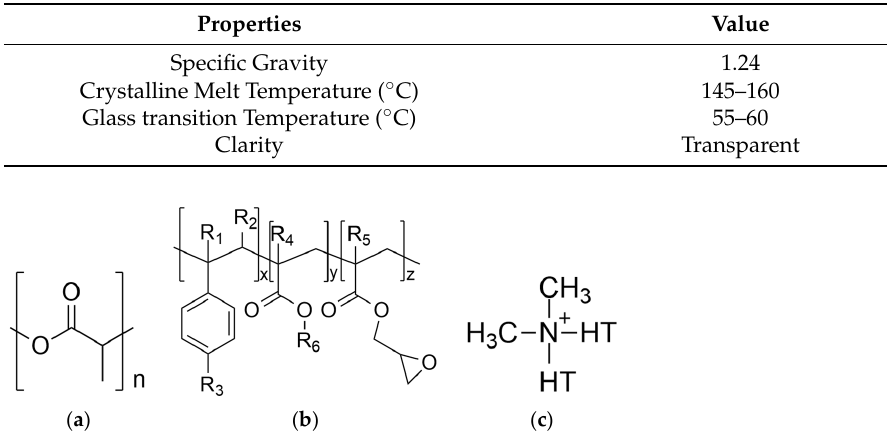
Figure 1. Chemical structures of ( a ) PLA, ( b ) Joncryl and ( c ) modified of Cloisite ® 20A.